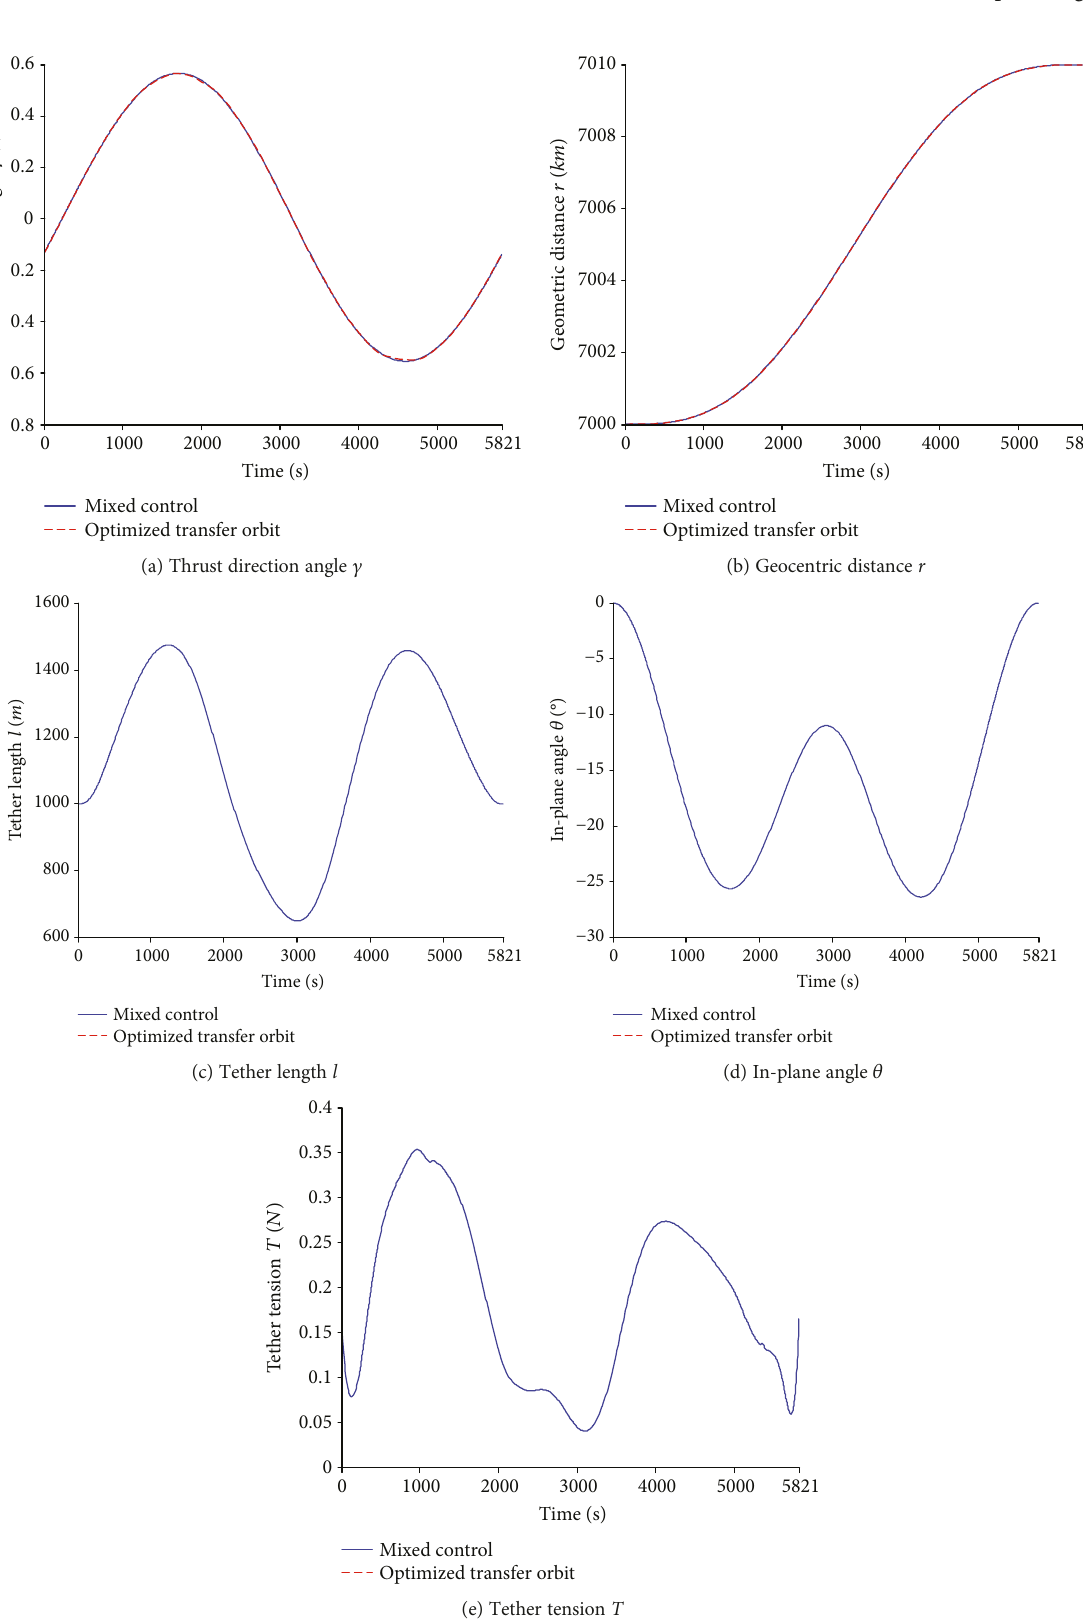
Figure 7: Time optimal control of the tethered system under mixed